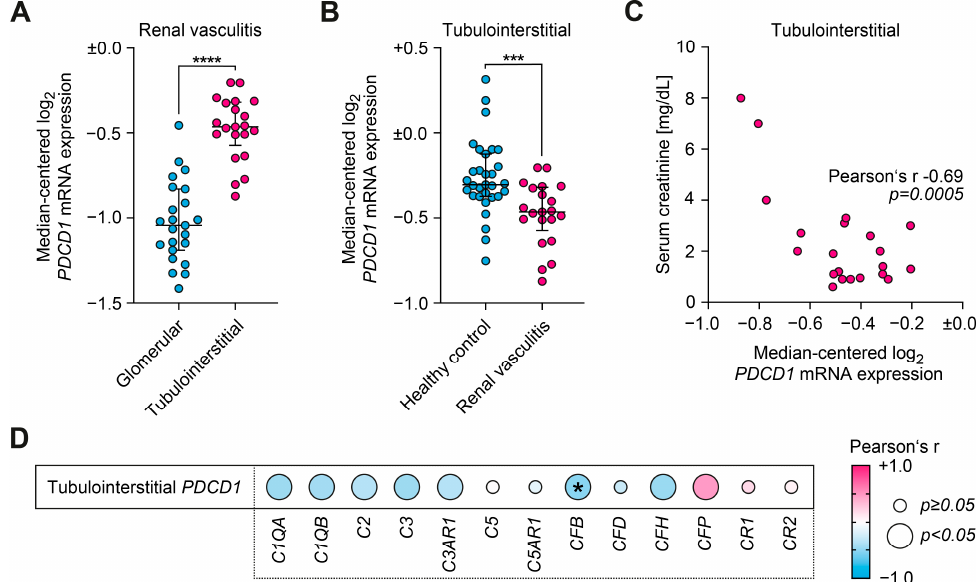
Figure 3. PD-1 associates with decreased local synthesis of complement factor B. ( A ) Direct comparison between glomerular (n = 23) and tubulointerstitial median-centered log 2 PDCD1 mRNA expression (n = 21) in renal vasculitis; comparison of groups was performed using unpaired t test (**** p < 0.0001). PDCD1 mRNA expression was predominantly found within the tubulointerstitial as compared to the glomerular compartment. ( B ) Direct comparison of tubulointerstitial median-centered log 2 PDCD1 mRNA expression between healthy controls (n = 31) and renal vasculitis (n = 21); comparison of groups was performed using unpaired t test (*** p < 0.001). PDCD1 mRNA expression was significantly lower in ANCA-associated renal vasculitis as compared to healthy control kidneys. ( C ) Correlations between tubulointerstitial median-centered log 2 PDCD1 mRNA expression and serum creatinine levels (n = 21) with Pearson’s r and significance level are shown. Loss of intrarenal PDCD1 mRNA expression correlated with increased serum creatinine measurements. ( D ) Correlations between tubulointerstitial median-centered log 2 mRNA expression levels of PDCD1 and various complement components including healthy control kidneys (n = 31) and ANCA-associated renal vasculitis (n = 21) are shown by heatmap reflecting mean values of Pearson’s r. Circle size represents significance level in the univariate analysis, asterisk (*) in the multivariate analysis. PDCD1 mRNA expression associated with decreased expression levels of CFB